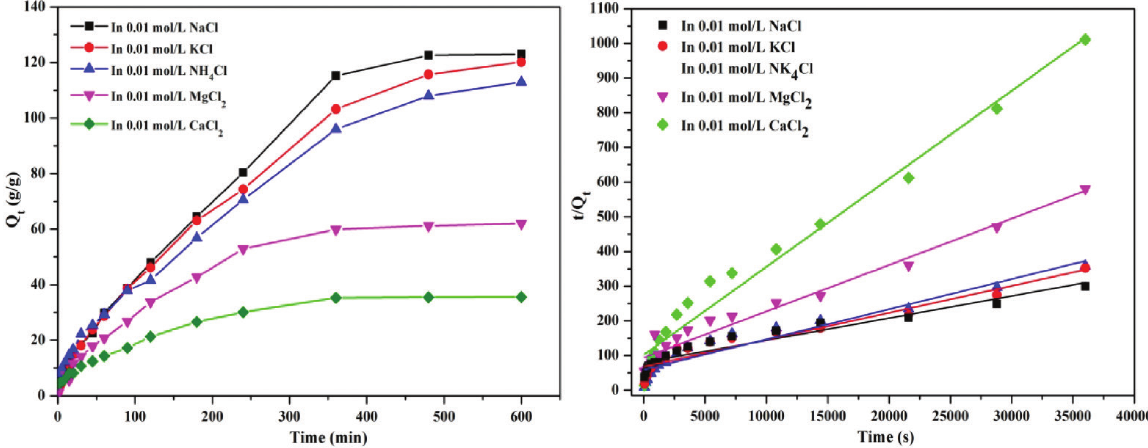
Figure 9: The swelling capacity (a) and kinetics (b) of SC-g-PAA/PAM/Urea in different saline solution.